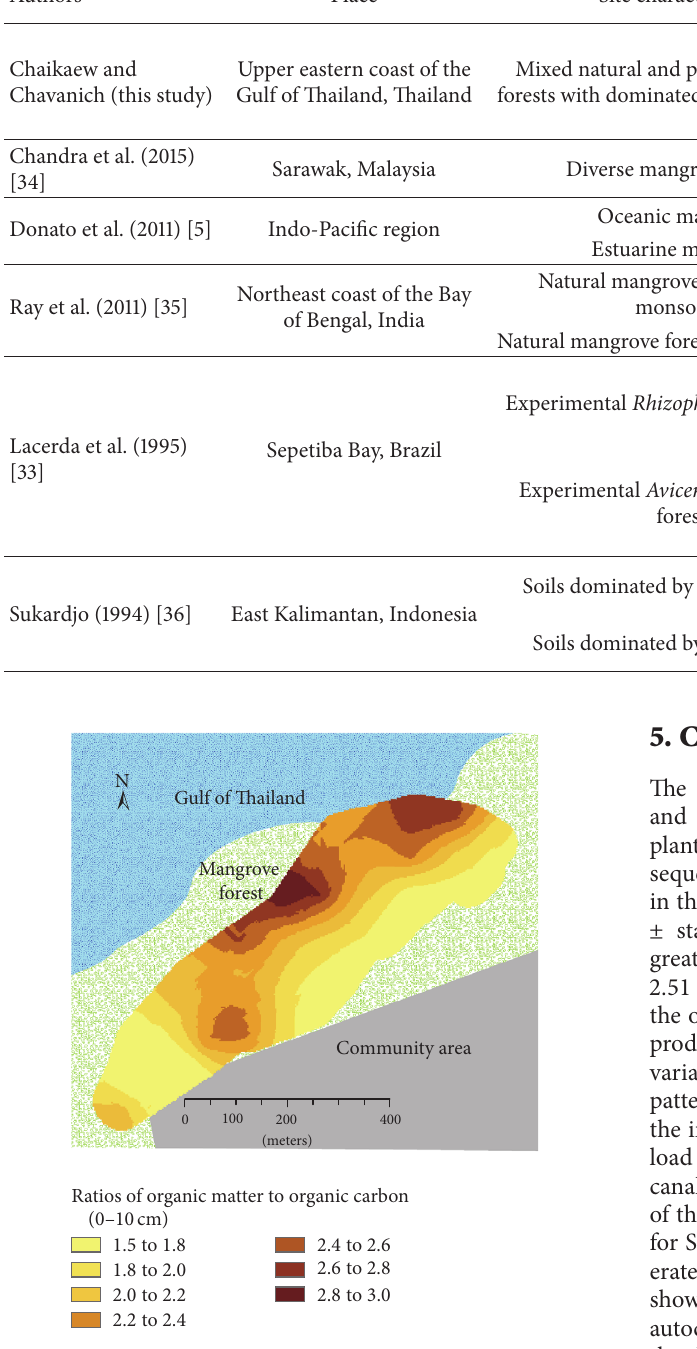
Figure 4: Ratios of soil organic matter obtained by loss on ignition (LOI) and organic carbon measured by gas analyzer based on the ordinary krigged estimated (Figure 2(a) divided by Figure